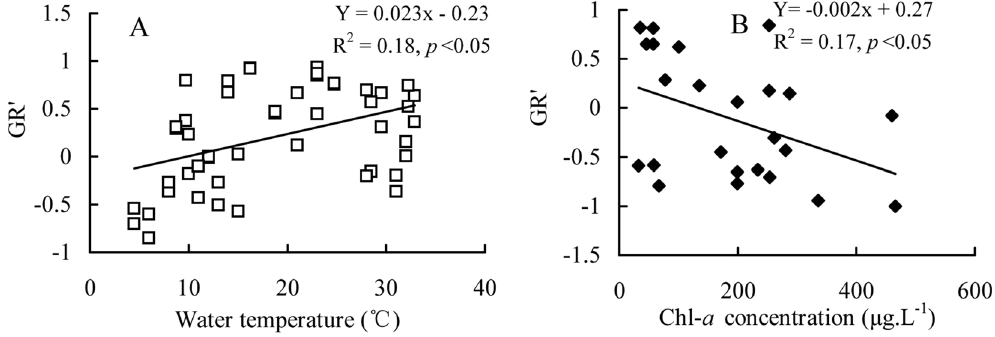
Figure 3. Relationships between GR ′ and water temperature as well as Chl- a concentration. ( A : Lake Jinghu, B : Lake